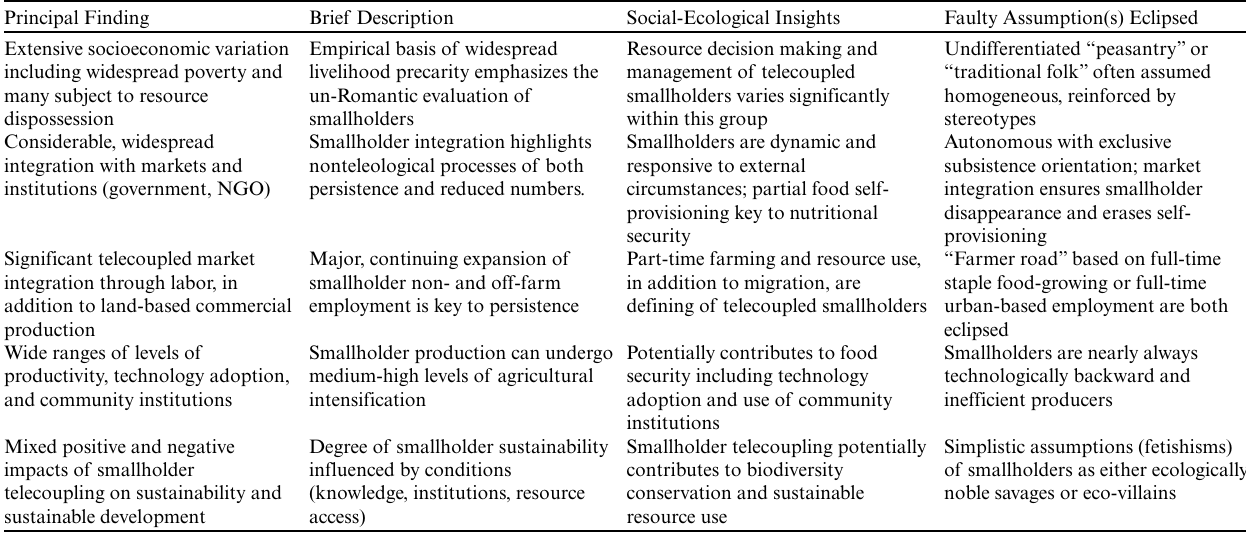
Table 5 . Smallholder social-ecological systems amid telecoupling: summary findings and new